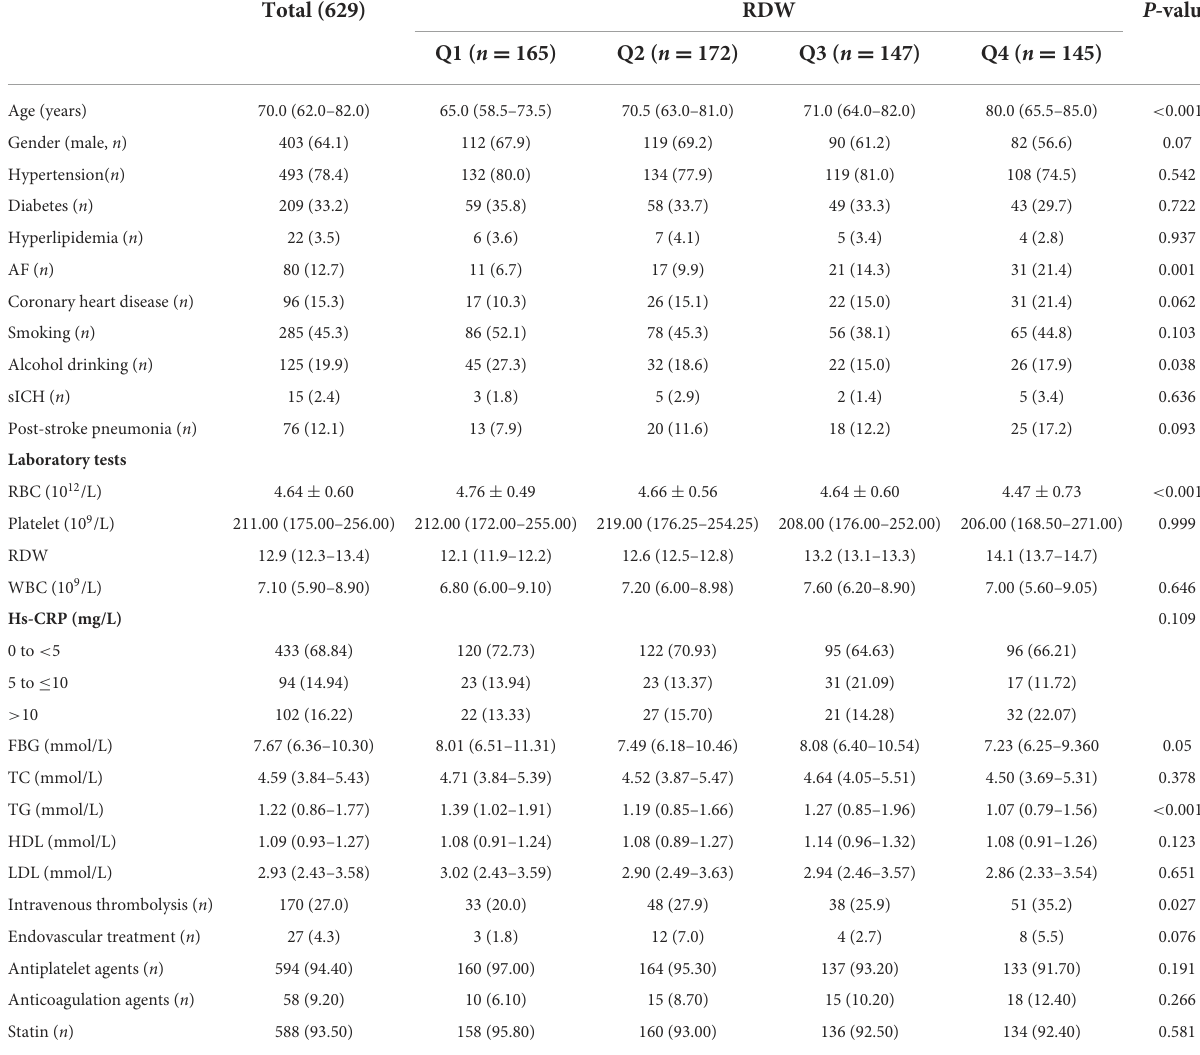
TABLE 1 Baseline characteristics of study patients according to quartiles of RDW.